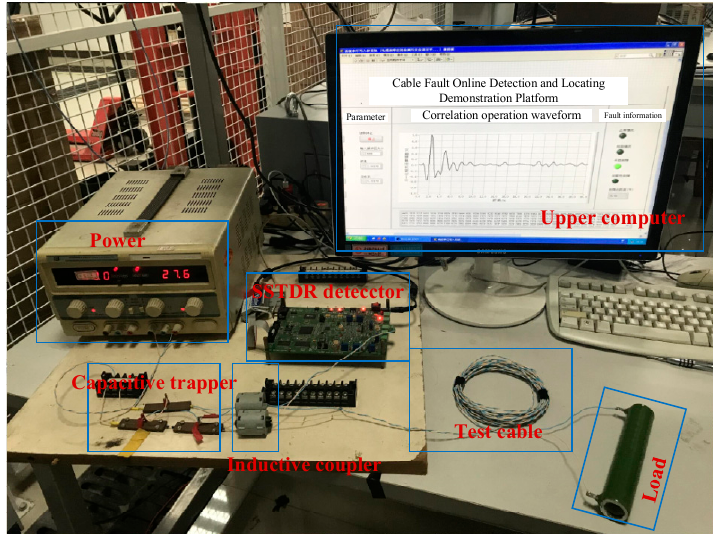
Figure 9. Experimental platform for inductive directional non-intrusive cable fault diagnosis.